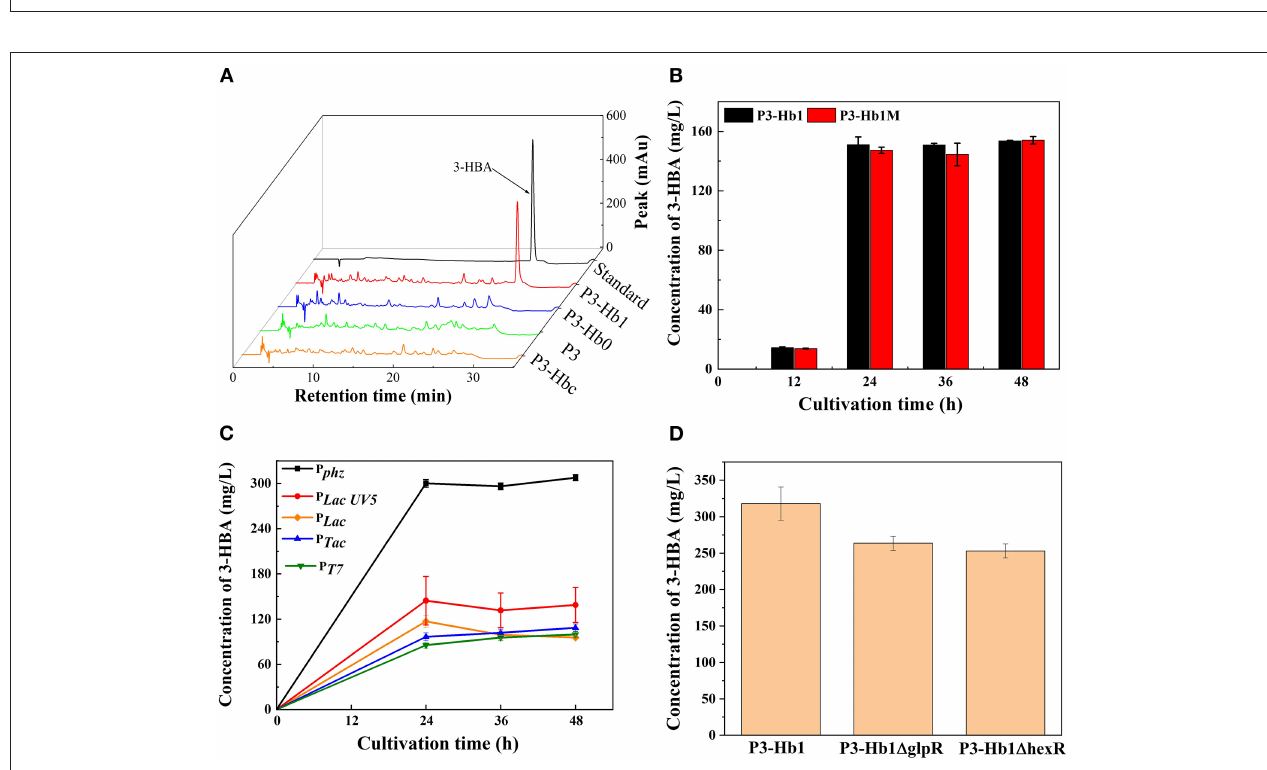
FIGURE 3 | Culture profiles of various 3-HBA-producing transformants. (A) HPLC profiles of various transformants; (B) The amount of produced 3-HBA in the cultures of P3-Hb1 and P3-Hb1M; (C) The amount of produced 3-HBA in the cultures when using different promoter to express hyg5 ; (D) The amount of produced 3-HBA in the cultures of P3-Hb1 1 glpR and P3-Hb1 1 hexR . Data are presented as the mean ± standard deviation of three independent experiments ( n = 3).